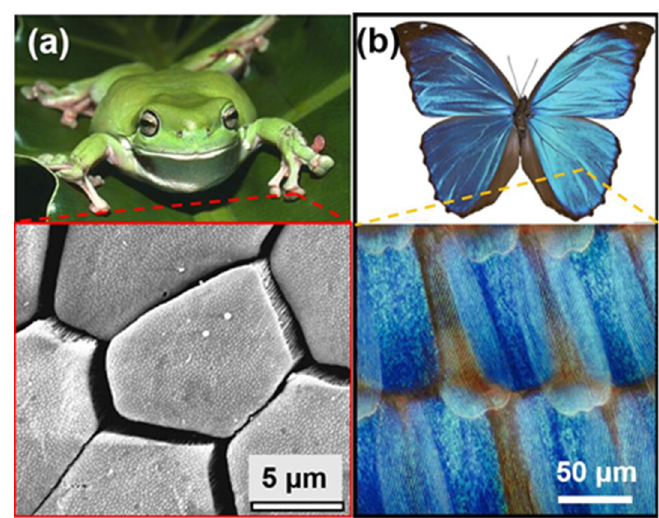
Figure 1. ( a ) Photograph of tree frog, with an inset showing the SEM of hexagonal epithelial cells with much finer pegs on toe pad epidermis [24]; ( b ) Photograph of Morpho butterfly, with an inset showing the scales with corrugated ridges of its wings.